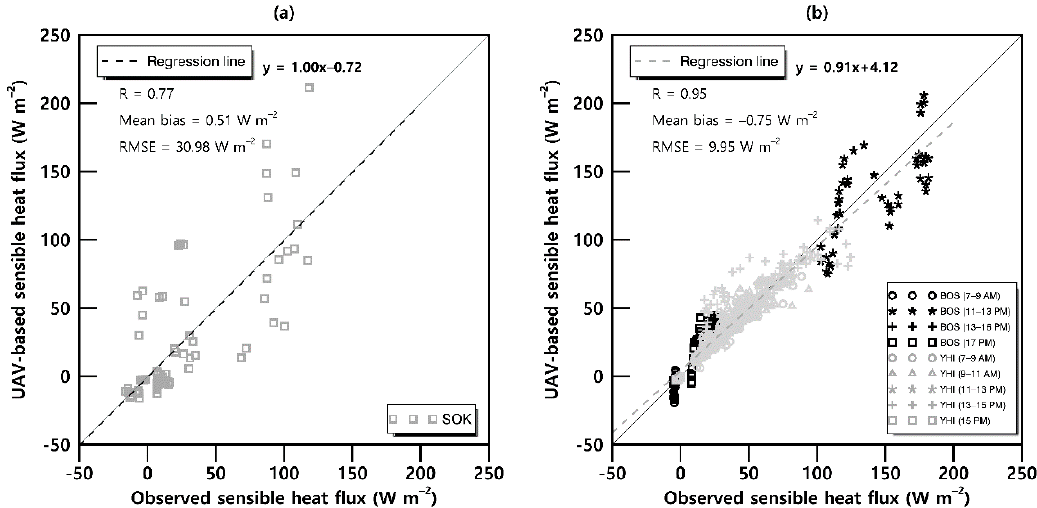
Figure 8. ( a ) Comparison of UAV-based heat fluxes (H b_AWSUAV ) with observed heat fluxes (H) at SOK and ( b ) comparison of UAV-based heat fluxes (H b_UAVUAV ) with observed heat fluxes (H) at BOS and YHI.